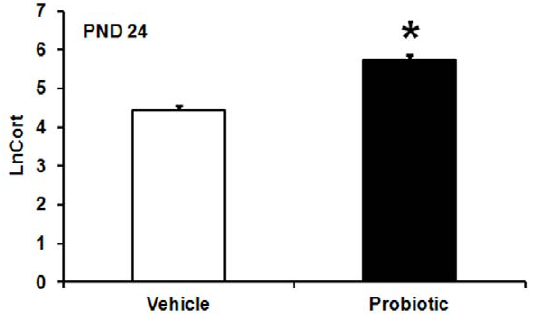
Figure 2. Effect of maternal probiotic intervention on neonatal corticosterone levels. Effect of maternal probiotic intervention on natural log transformed plasma corticosterone concentrations (LnCort, least squares means + SE) at PND 24. Initial corticosterone data were expressed as ng/mL plasma. The filled bar represents animals born to probiotic-treated dams (n=40) and the hollow bar represents animals born to vehicle-treated dams (n=45). An asterisk (*) indicates statistical significant difference ( p # 0.05).